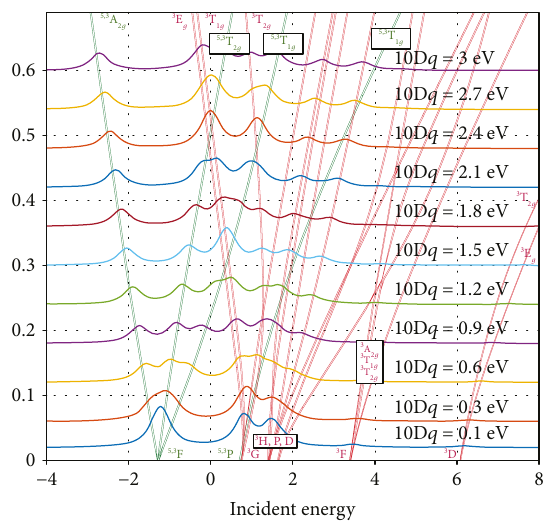
Figure 24: E ff ect of the O crystal fi eld on the 1s XAS projections of h the calculated 1s2p RIXS spectra for Cr 4+ ( 3d 2 ). The corresponding ELD overlay illustrates the distribution of the reachable intermediate state terms contributing in 1s